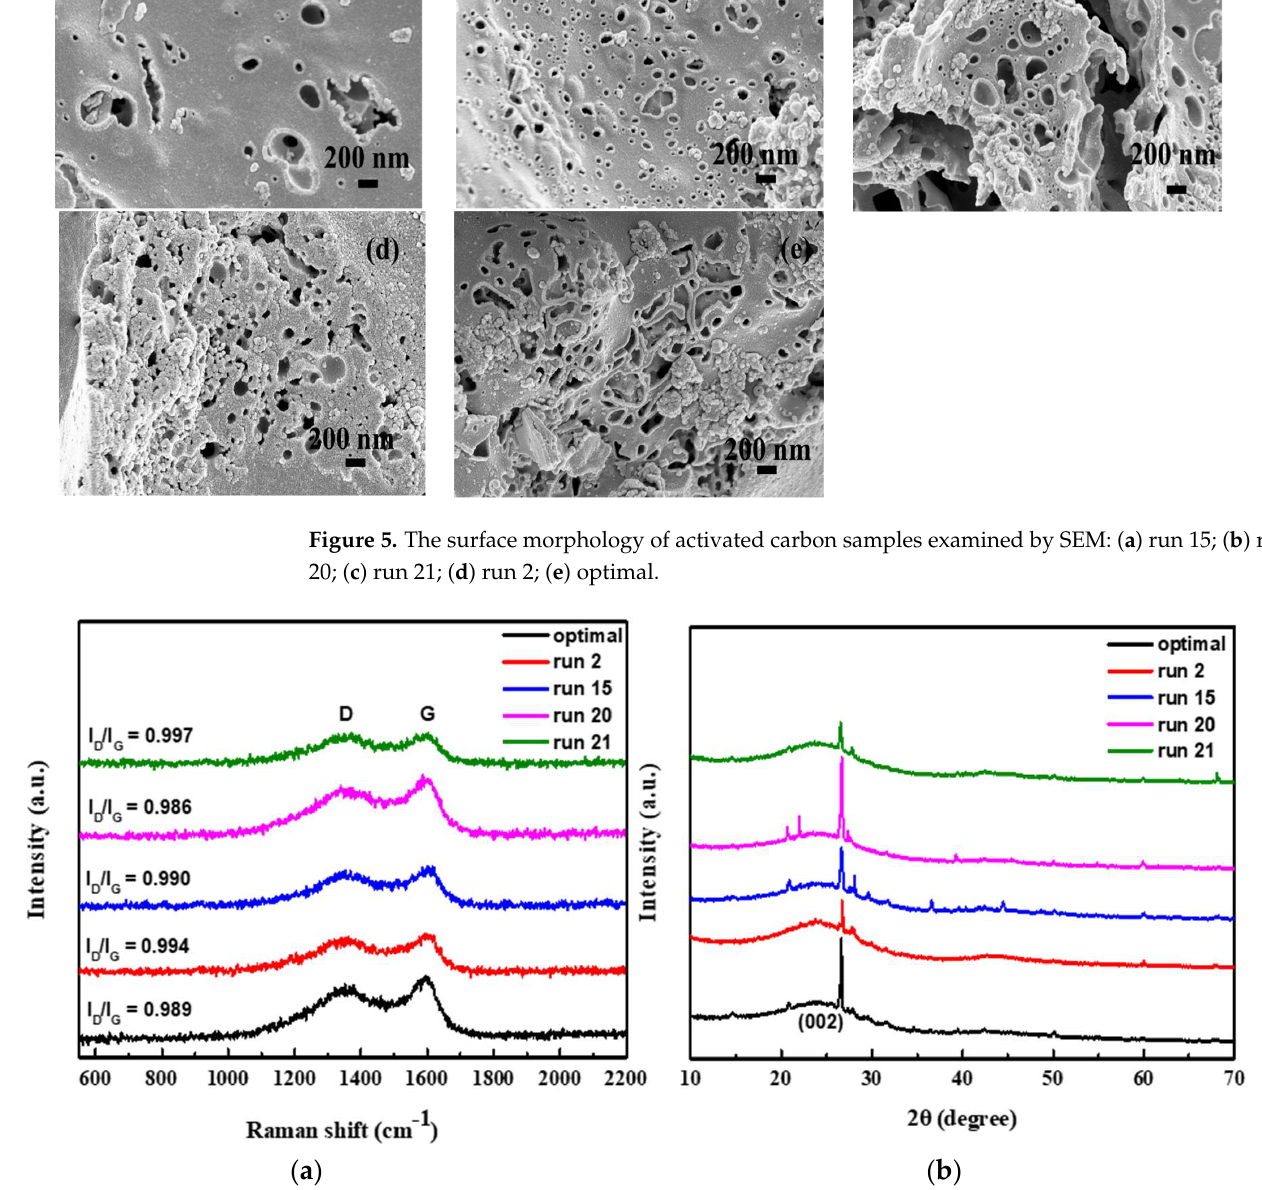
Figure 6. The degree of graphitization of the sample by the I D /I G -value of Raman shift ( a ); XRD patterns of the as-obtained different porous carbon ( b ).